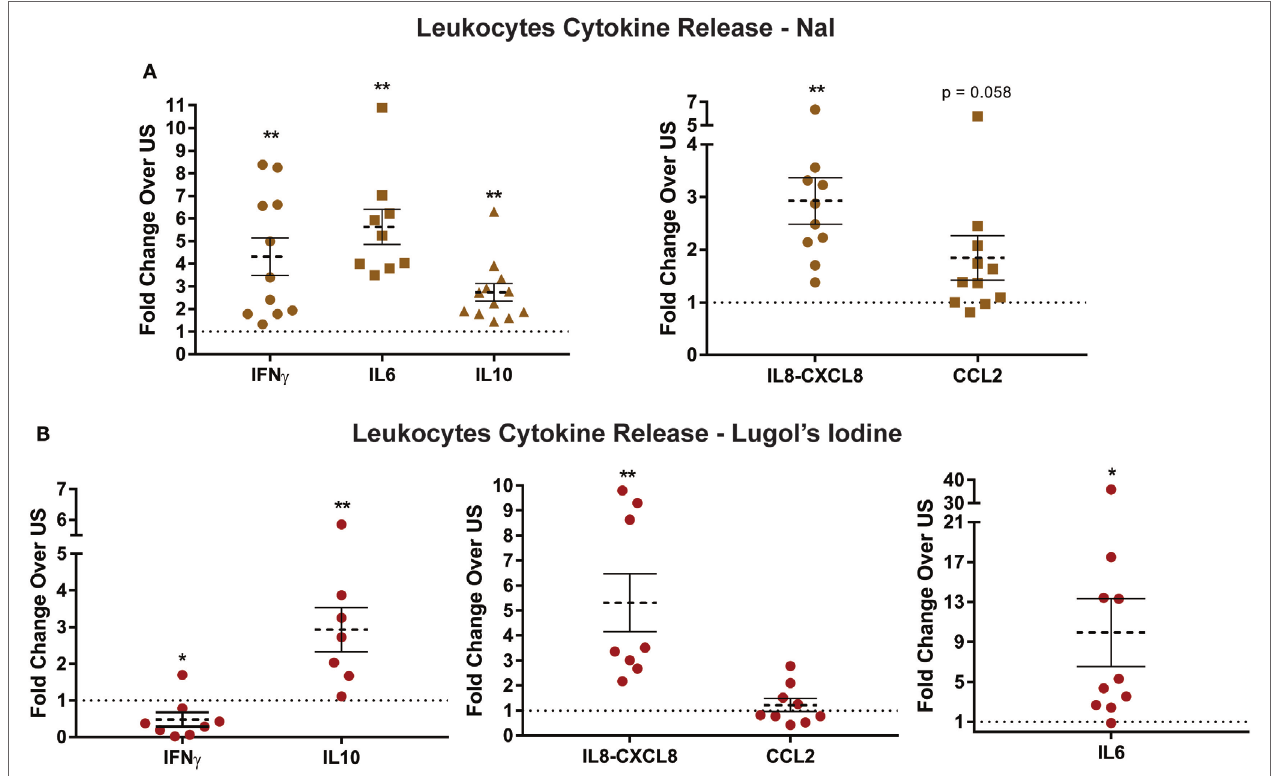
FigUre 3 | Increased release of cytokines and chemokines by iodide-treated leukocytes. (a) 5 × 10 6 leukocytes were left unstimulated (US) with PBS or treated with 1 mM NaI for 72 h. The supernatants were collected, and protein levels of cytokines/chemokines were analyzed utilizing enzyme-linked immunosorbent assay. (B) Same as in panel (a) , but instead leukocytes were incubated with 500 µM Lugol’s iodine for 72 h, and then the supernatant was analyzed for cytokine levels. Detected ranges for cytokine secretion are (IFN γ : 5–1,005 pg/mL, IL6: 10–2,500 pg/mL, IL10: 26–482 pg/mL, IL8-CXCL8: 0.3–230 ng/mL, and CCL2: 15–65 ng/mL). Cytokine concentrations were normalized based on fold changes over each US pair and was then averaged and graphed as fold increase ± SEM of at least seven